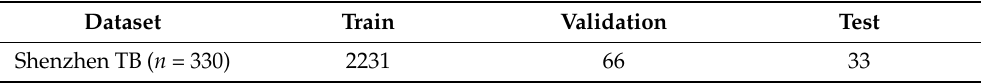
Table 1. Dataset and its respective patient-level train/validation/test splits. The value n denotes the total number of CXRs in the collection that shows radiological signs of